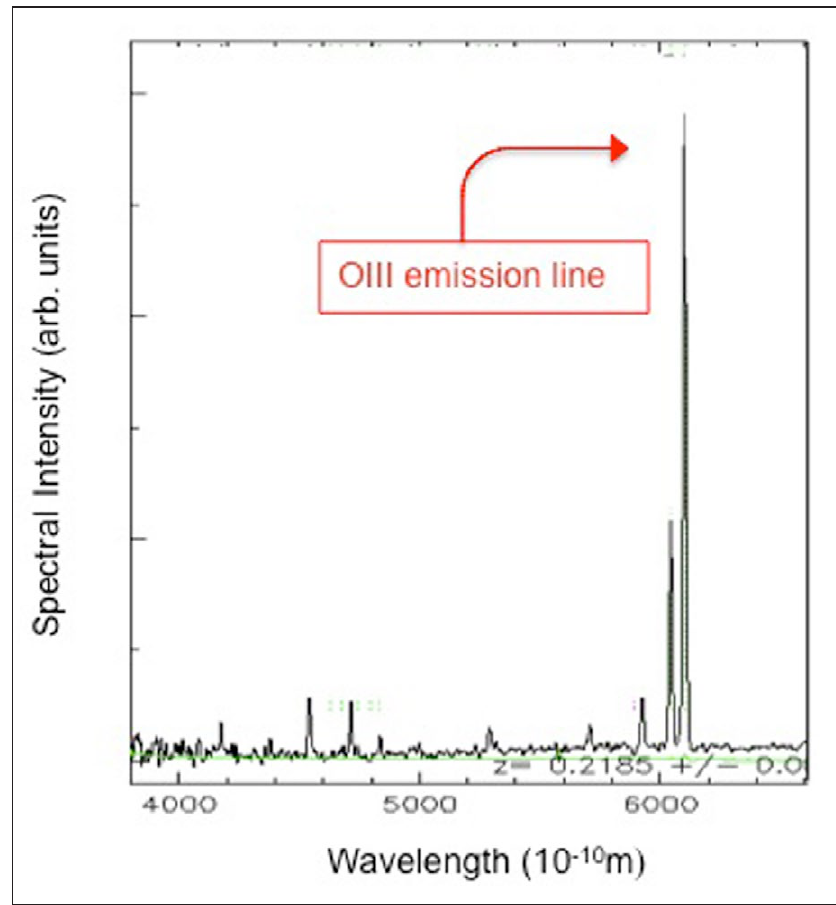
Figure 3: OIII emission spectrum: Spectrum posted by zookeeperkevin in the “Object of the Day” thread on Dec.